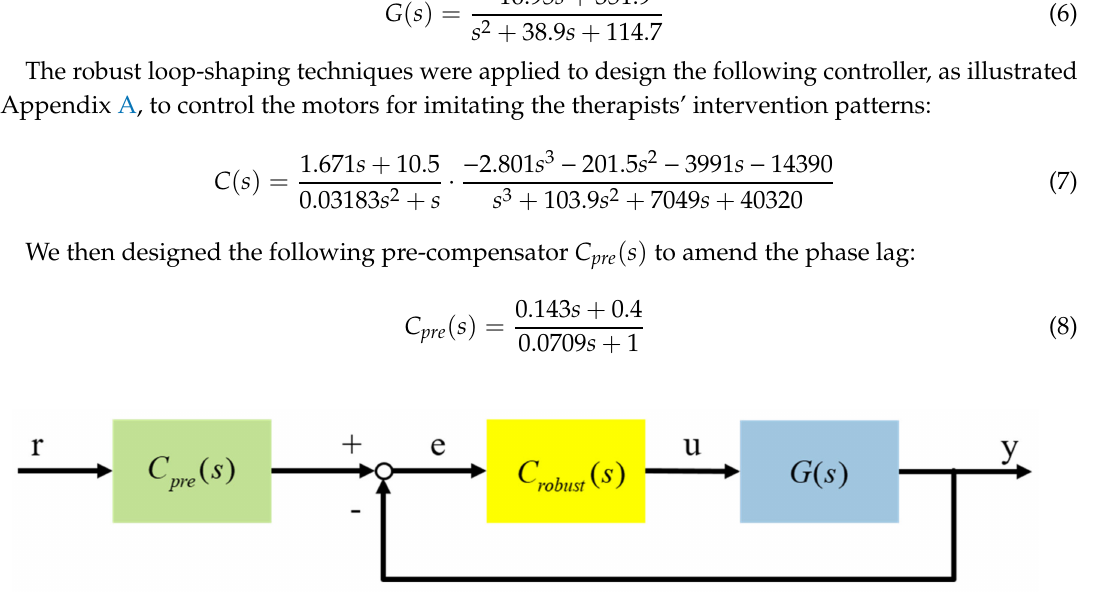
Figure 10. Block diagram of the motor control